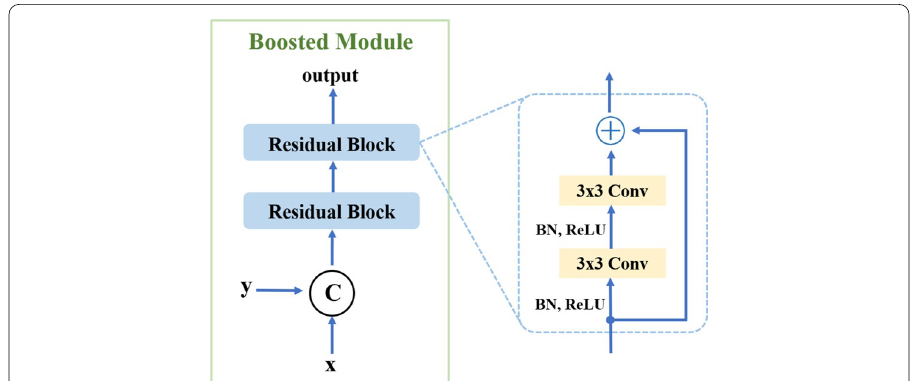
Fig. 4 The architecture of the boosted module. The two inputs of the boosted module are first concatenated and passed through two residual blocks. Structure of the residual block is also amplified